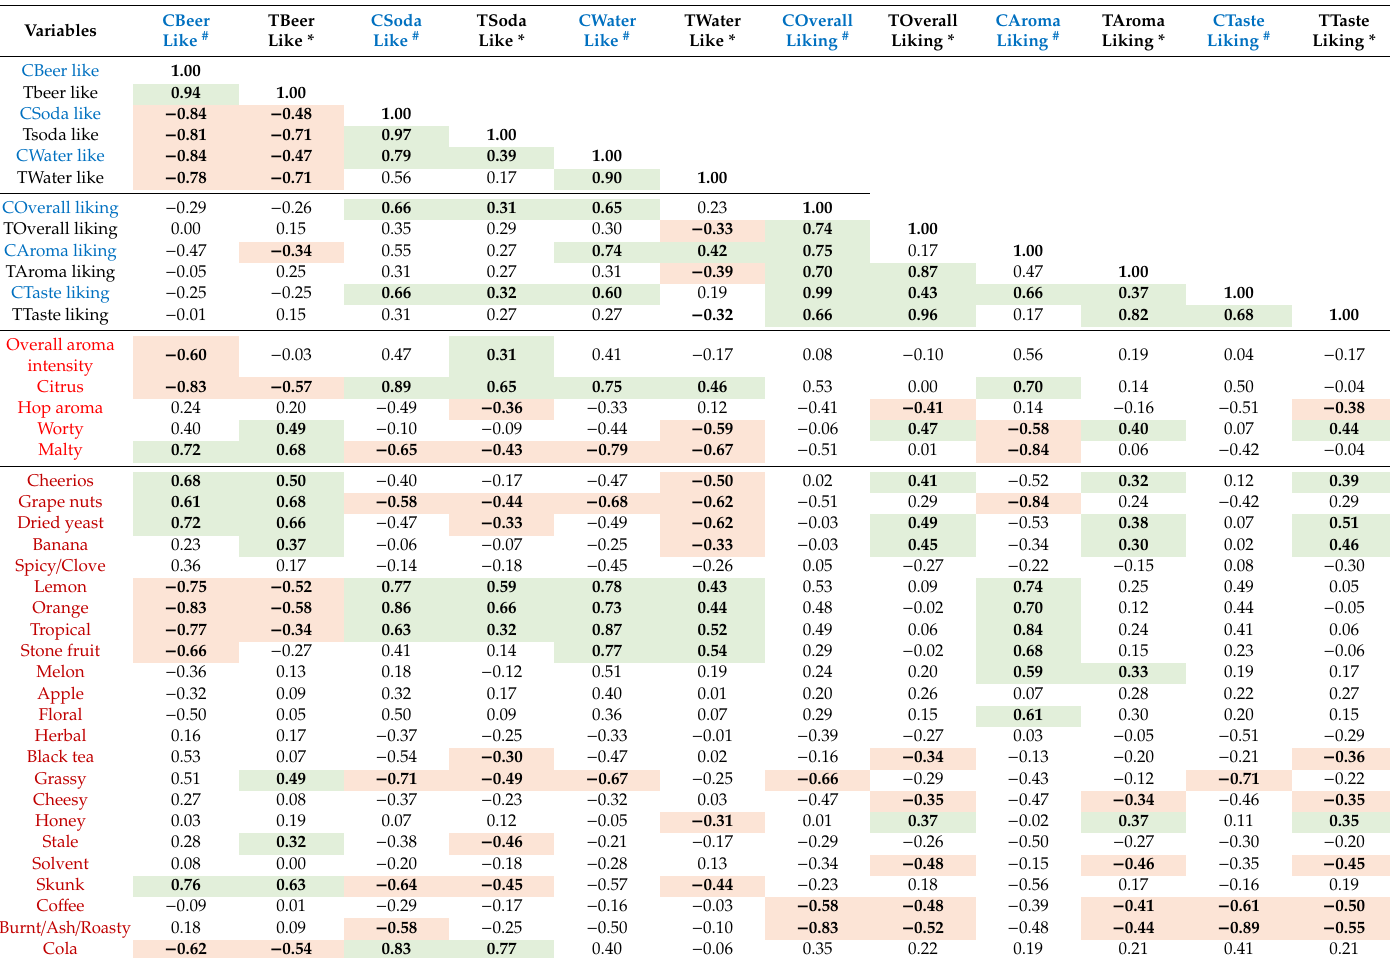
Table 2. Pearson correlation matrix of least square means for both the trained and consumer panel beer, soda, water similarity ratings, hedonic data, and aroma